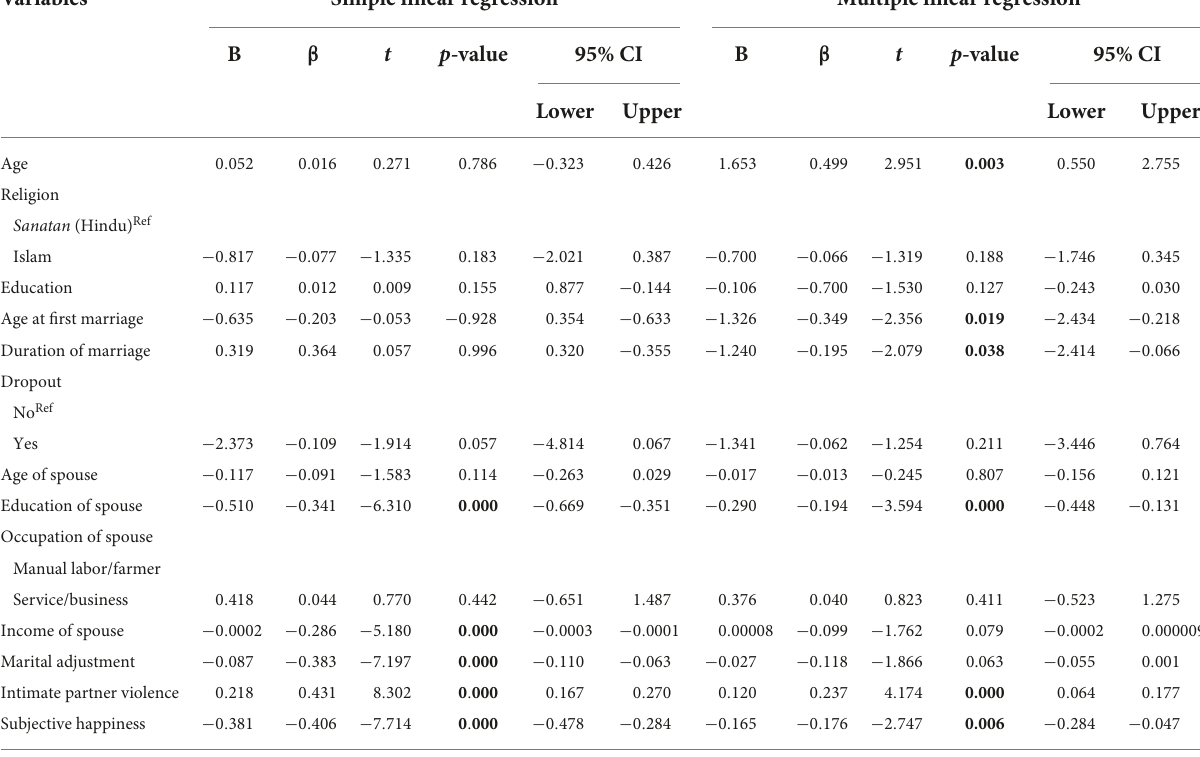
TABLE 3 Predicting anxiety among early married girls during the pandemic. Variables Simple linear